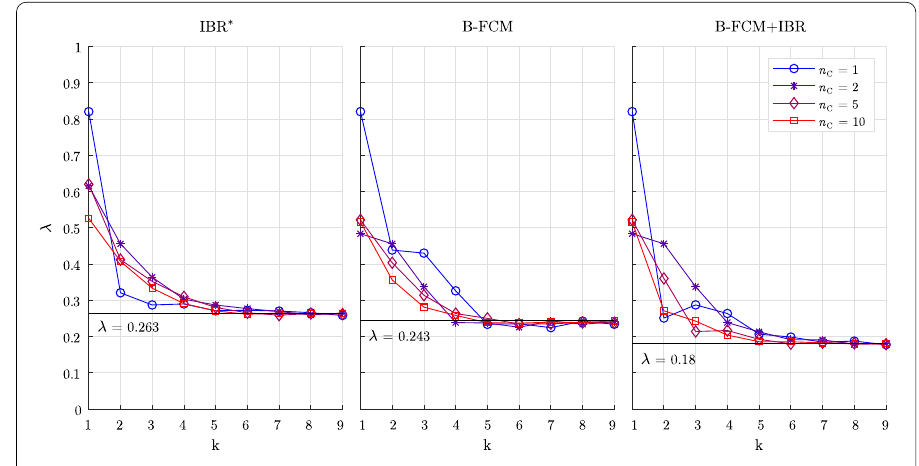
Fig. 24 Compression ratio of the IPs λ of the investigated methods when applied to the perforated plate depicted in Fig. 21. For all curves p = 10 was used, resulting in ( p + 1) × ( p + 1) = 121 IPs per sub-cell